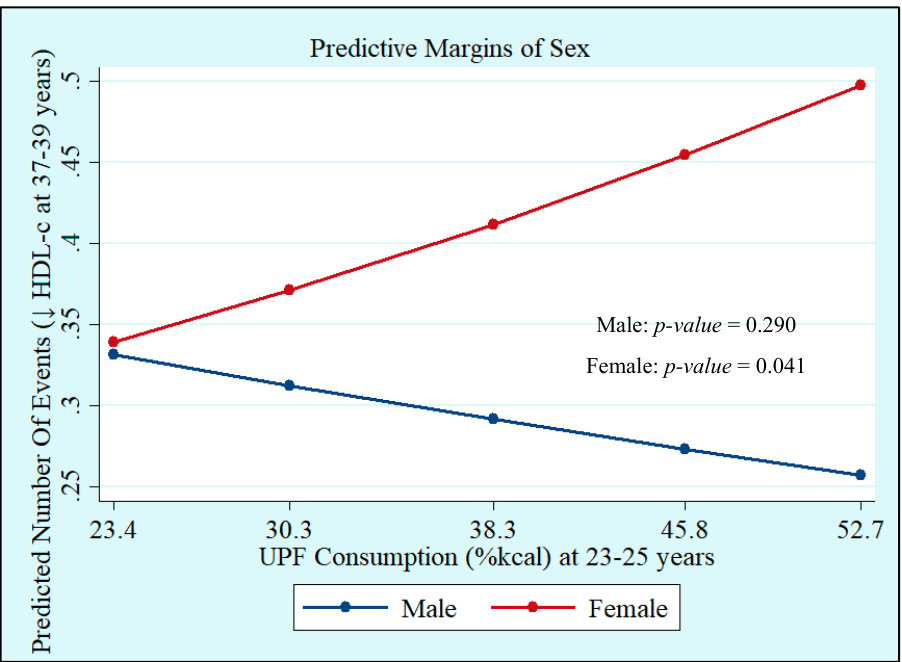
Figure 2. Incidence of low high-density lipoprotein-cholesterol (HDL-c) at 37–39 years by sex according to ultra-processed food (UPF) consumption at 23–25 years in %kcal. Ribeirão Preto Cohort 1978/79, São Paulo, Brazil.